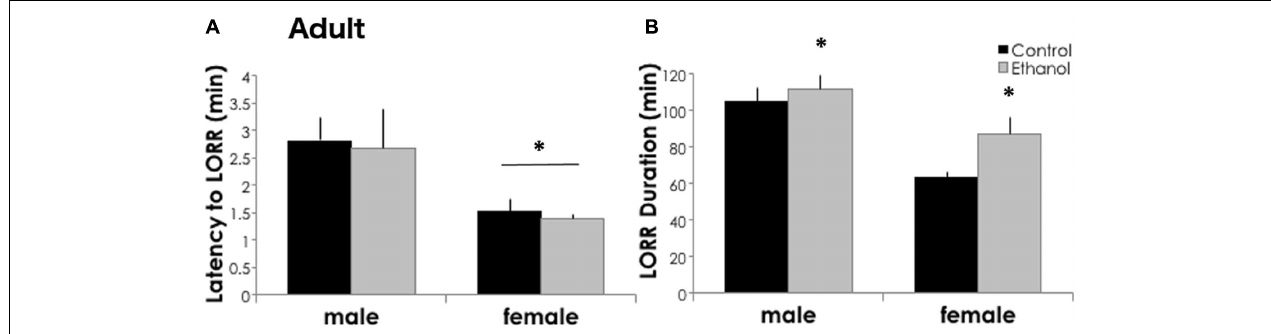
FIGURE 5 | Ethanol sensitivity is greater in ethanol-exposed mice in adulthood. (A) Latency to lose the righting reflex was significantly shorter in adult females ( n = 13/group) as compared to males ( n =19–20/group). ∗ p < 0.05, main effect of sex by Two-Way ANOVA. But did not differ between treatment groups. (B) In adulthood, adolescent ethanol exposure increased LORR duration as adults. Data is presented as mean +/– SEM. ∗ p < 0.05, main effect of treatment by Two-Way ANOVA.